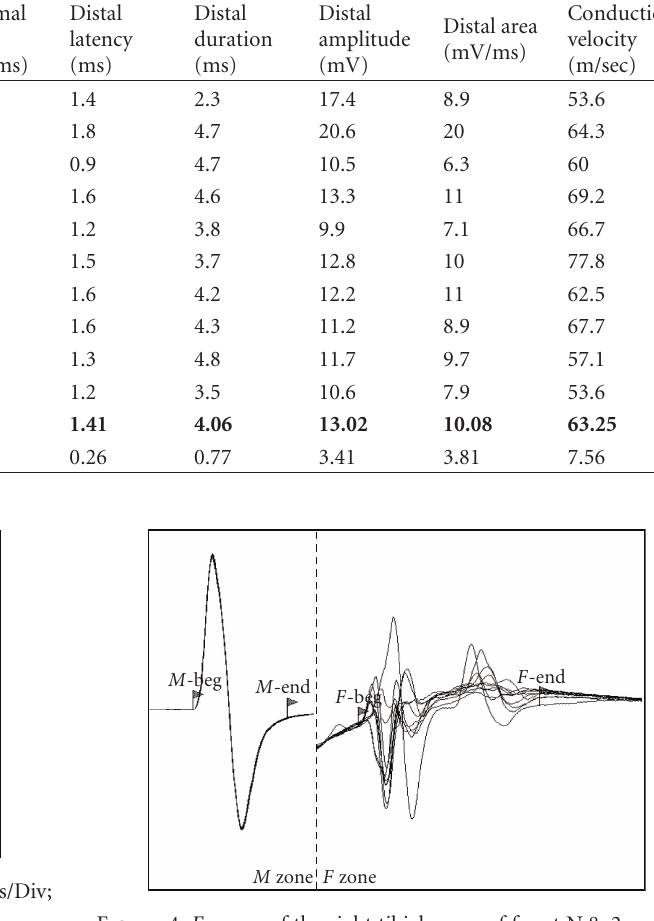
Figure 4: F waves of the right tibial nerve of ferret N.8. 2 ms/Div;